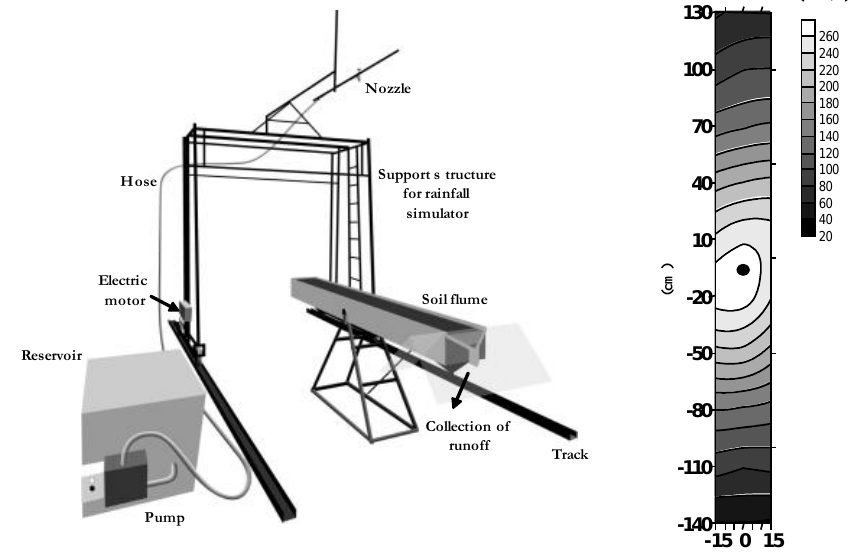
Fig. 1. Laboratory set-up (left) and spatial distribution of rainfall intensity (right), under the nozzle located at (0,0).